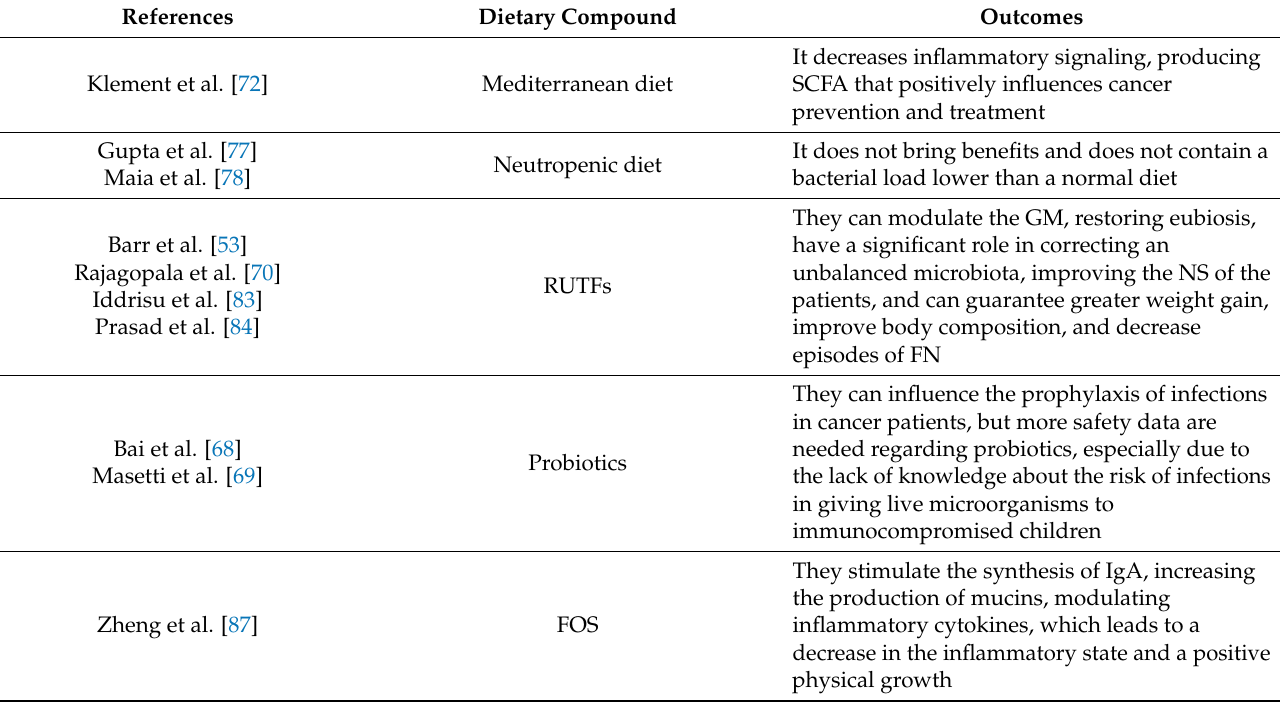
Table 6. Nutritional intervention studies in children with